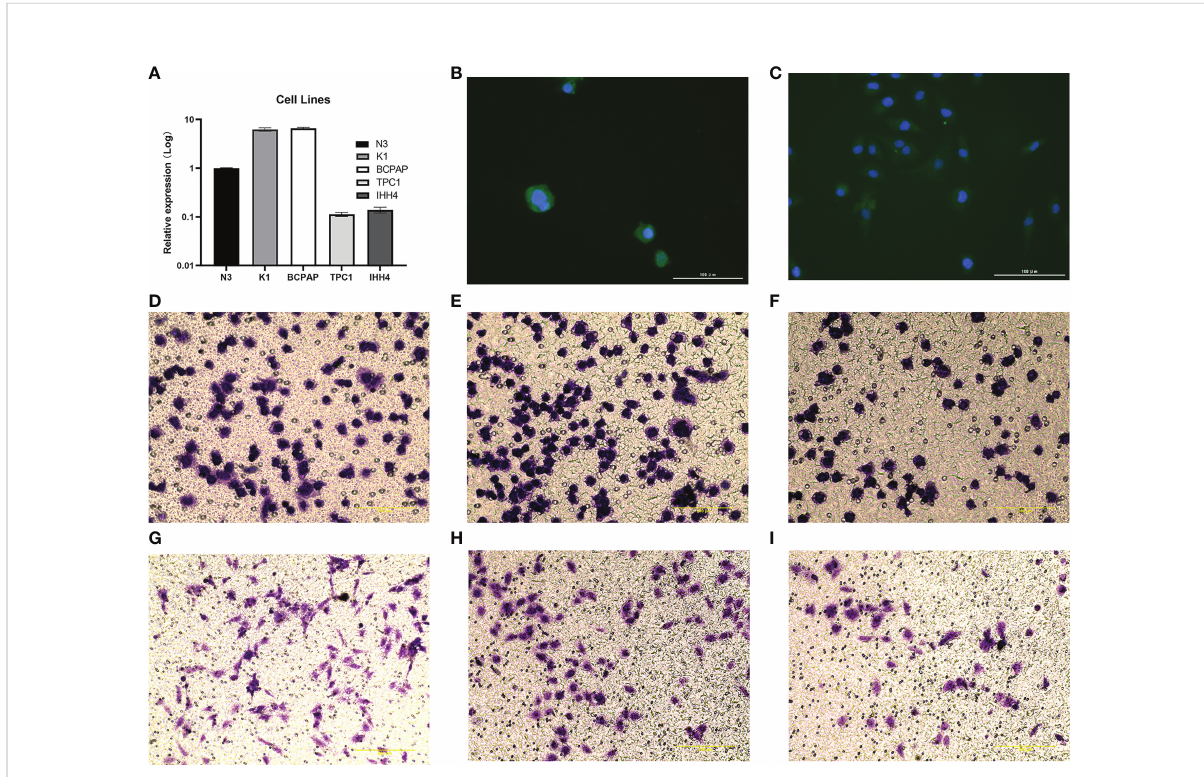
FIGURE 11 The expression of CADM1-CADM1 in PTC cell lines. (A) The different expression of CADM1 in N3, K1, BAPAP, TPC1 and IHH4 cell lines. (B) Results of immuno fl uorescence staining of IHH4 cells, which were mainly located in cytoplasm and a little in nucleus. (C) Results of immuno fl uorescence staining of TPC1 cells, which were also mainly located in cytoplasm and a little in nucleus. (D – I) Overexpression of CADM1 in IHH4 cell lines by pEGFP-C1-CADM1 transfection inhibits cell migration. D, Blank control (IHH4) (×200). E, pEGFP-C1 (NC) (×200). F, pEGFP-C1-CADM1 (CADM1) (×200). (G – I) Overexpression of CADM1 in TPC1 cell lines by pEGFP-C1-CADM1 transfection inhibits cell migration. G, Blank control (TPC1) (×200).H, pEGFP-C1 (NC) (×200). I, pEGFP-C1-CADM1 (CADM1)